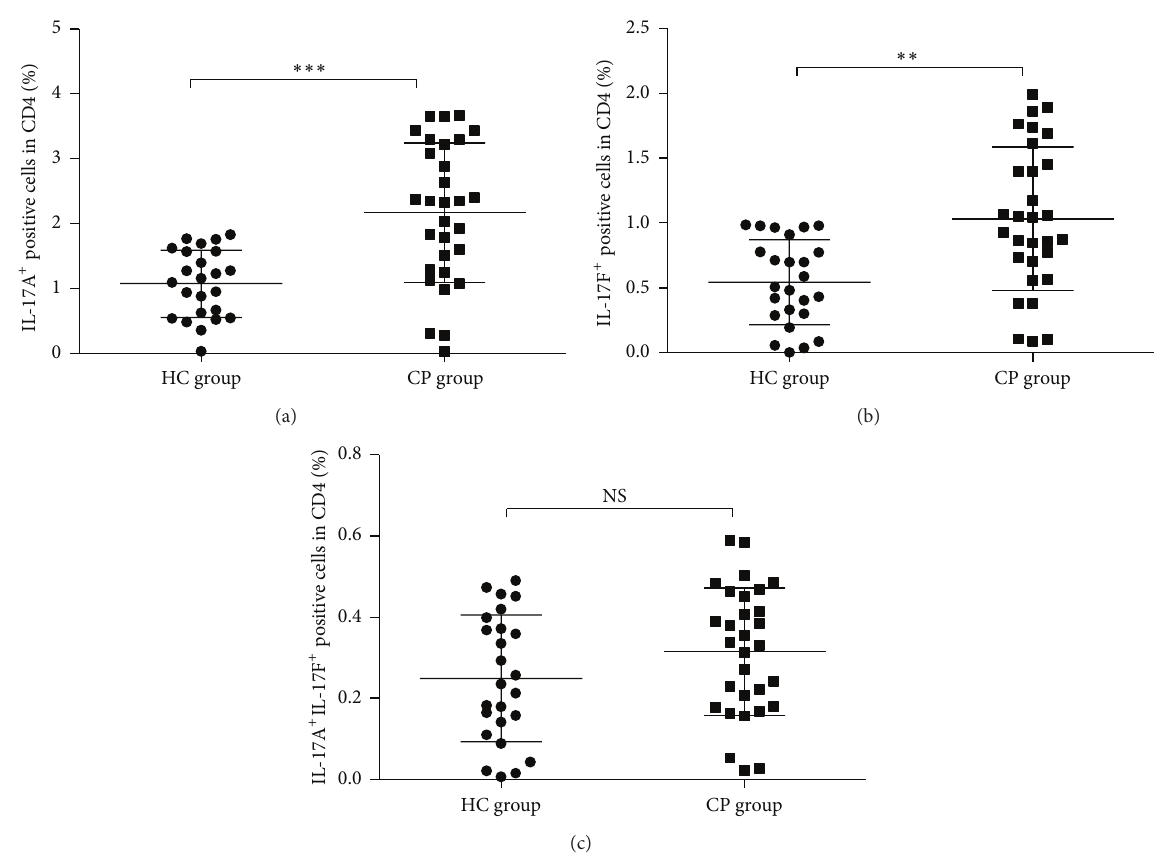
Figure 3: Statistical analysis of IL-17A + and/or IL-17F + Th17 cells expression level in CP and HC groups. ((a) IL-17A + IL-17F − Th17 cell; (b) IL-17A − IL-17F + Th17 cell; and (c) IL-17A + IL-17F + Th17 cell.)